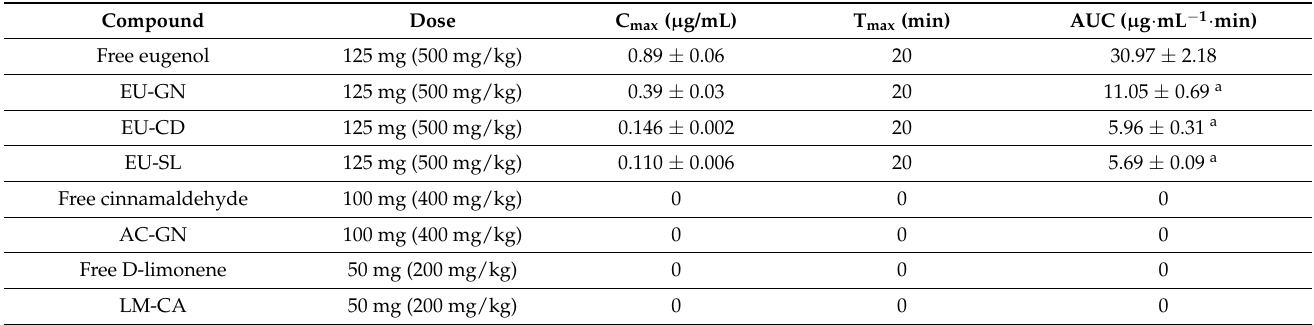
Table 4. Pharmacokinetic parameters referred to cerebrospinal fluid (CSF) of eugenol, cinnamalde- hyde and D-limonene after oral administration to rats. Data are reported as mean ± SE ( n = 4). C max : maximum concentration obtained in CSF; T max : time of C max ; AUC: area under concentration from the end of infusion to last time of detection.